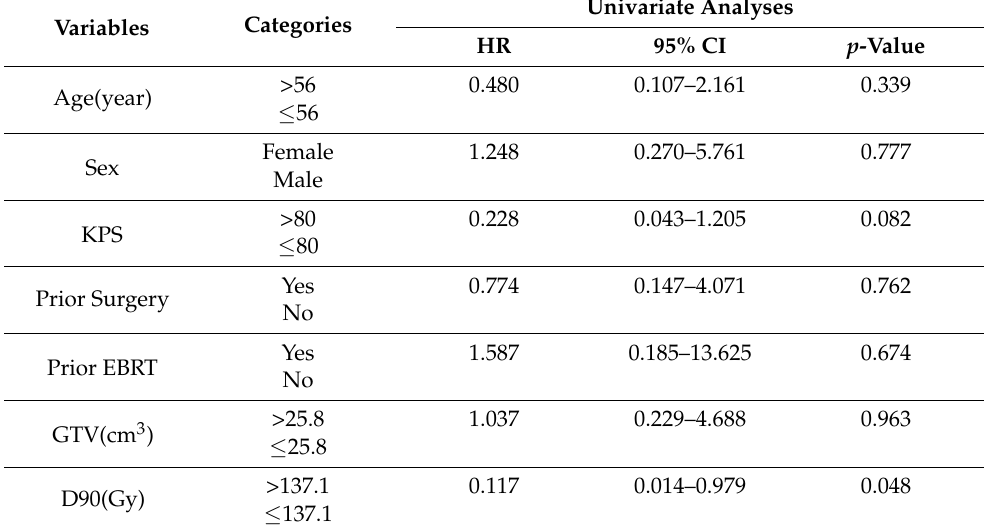
Table 2. Univariate analyses for